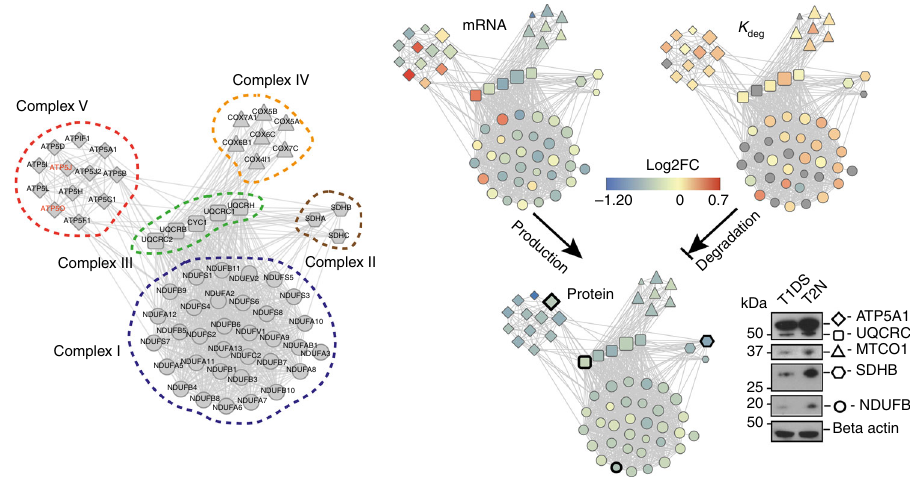
Fig. 7 Co-regulation of mitochondrial protein complexes in T21. Co-regulation of mitochondrial complexes starts at the transcriptional level and gets uniform at protein level through protein level regulation and protein degradation processes. Proteins belonging to Complexes I – V are visualized by the nodes with shapes of circle, hexagon, rectangle, triangle, and diamond, respectively. The edges between nodes denote high-con fi dence protein interactions documented in STRING database (minimal combined score > 0.45). In the visualization panels of mRNA, protein, and K deg comparisons, the node size is proportional to the log 10 scale transformed protein copies. The color gradient of blue – yellow – red depicts the log 2 T1DS/T2N FC values. Standard gene symbols are used, with corresponding Swissprot IDs listed in Supplementary Data 2. The Western blots were performed for selected proteins in each mitochondrial protein complex, con fi rming their downregulations in